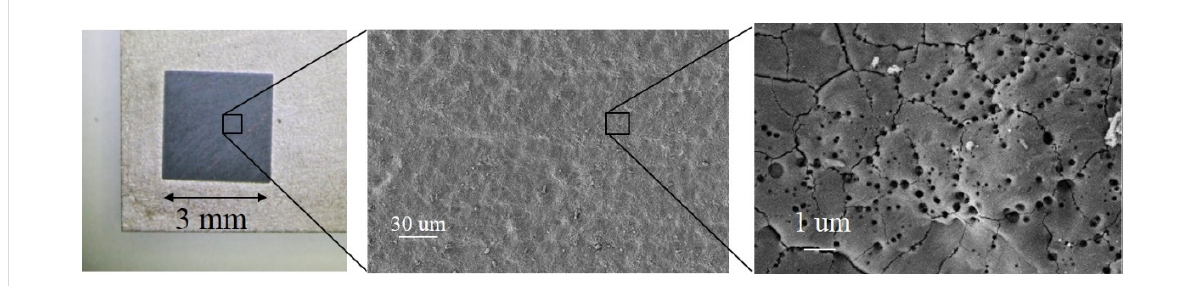
Figure 2: Left: Photograph of the irradiated sample. Middle: low-magnification SEM image of the surface after laser irradiation. Right: High-magnifica- tion image of the surface of black TiO x .